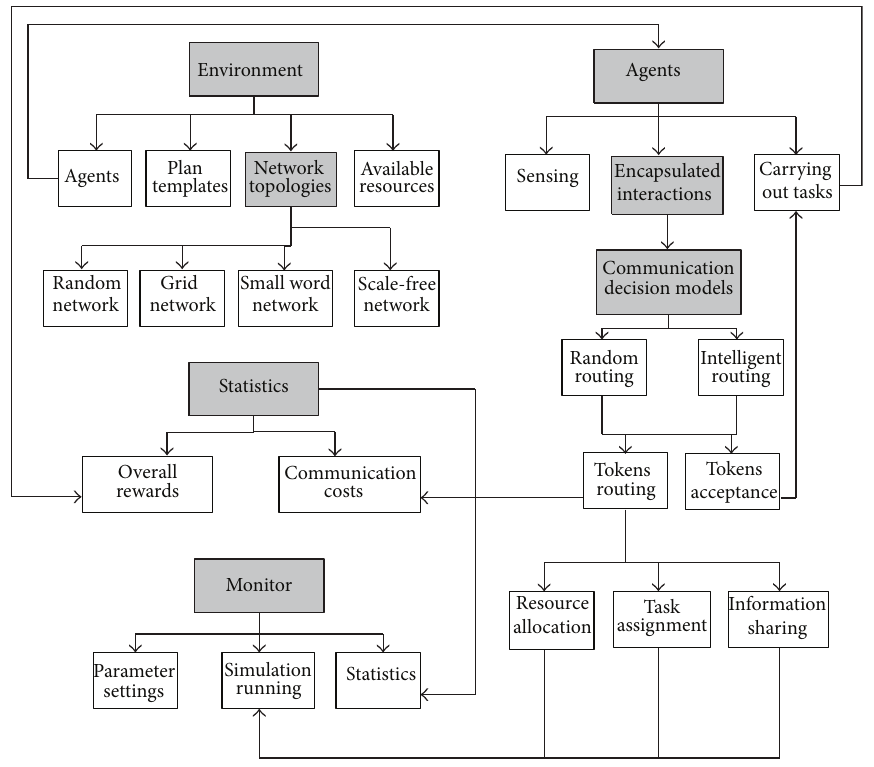
Figure 5: The architecture of CoordSim